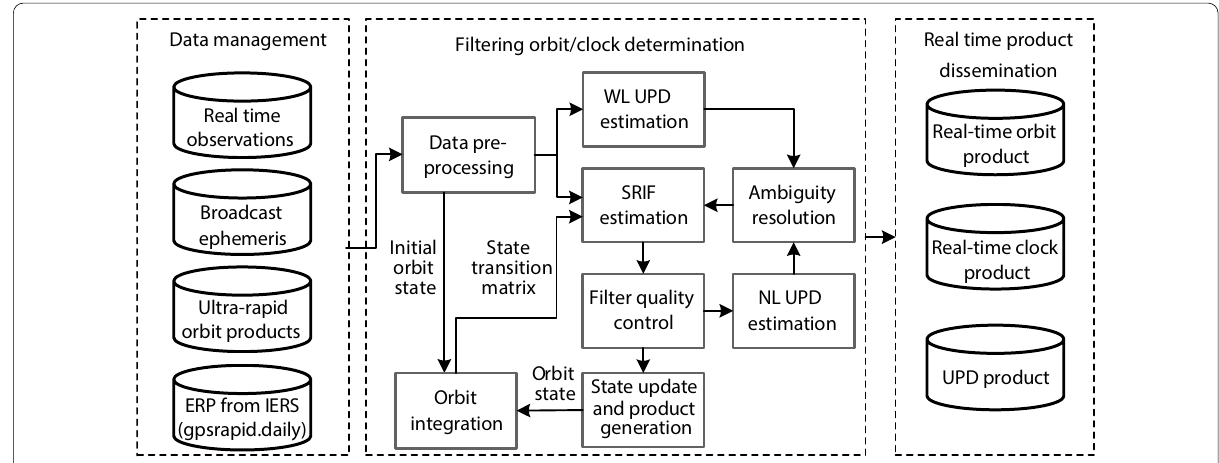
Fig. 4 Real-time filtering precision orbit determination software